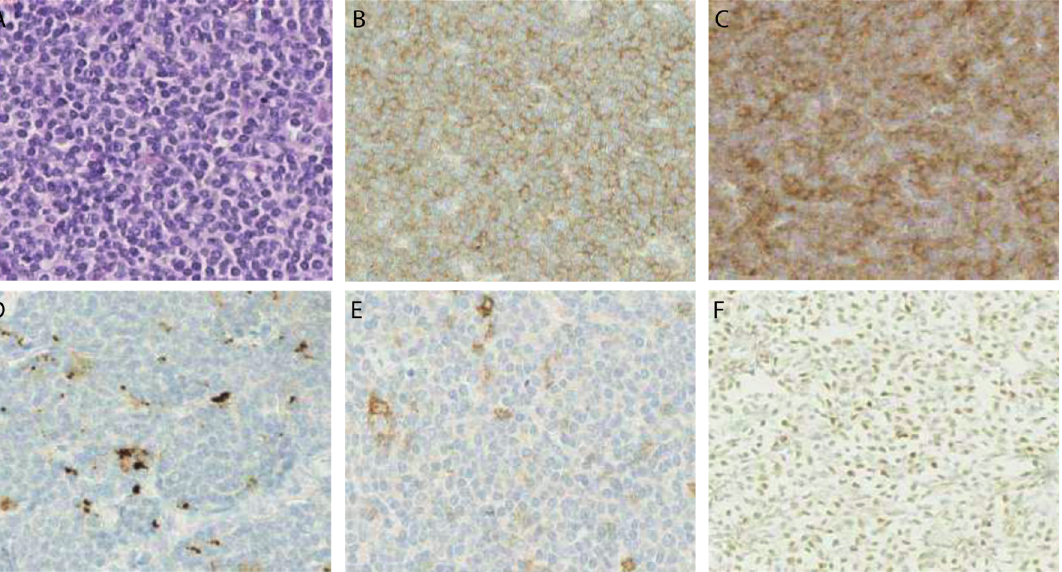
Figure 7. Micrographs of immunohistochemical stainings in one MCL patient sample. Sequential cuts of one MCL patient sample showing staining of ( A ) HE; ( B ) CD70; ( C) CD27; ( D) PD-L1; ( E) PD-1; and, ( F) nuclear staining of MCL cells for cyclin D1. Magnitude 40 × .